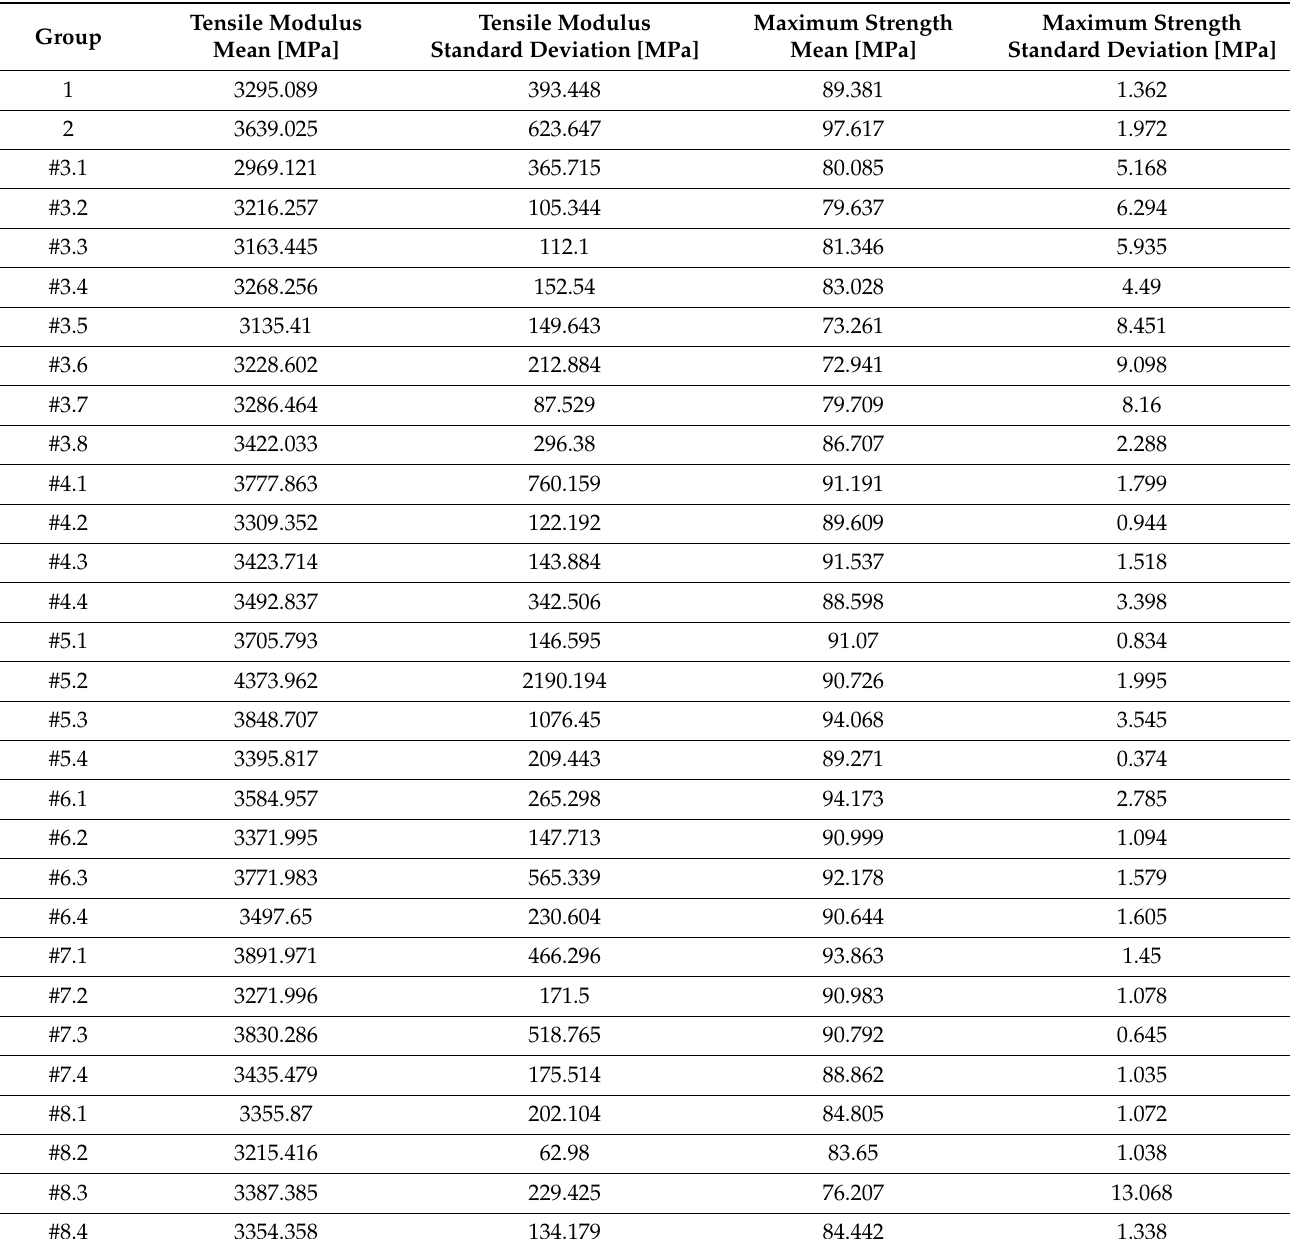
Table 3. An overview of the result of tensile testing of PEEK printed parts with different printing